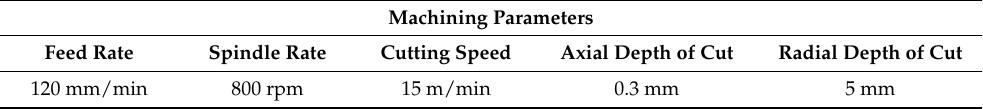
Table 2. Machining Parameters .